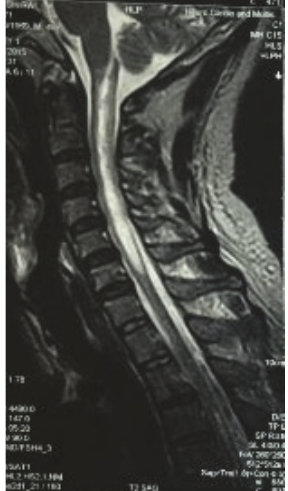
Figure 1: Magnetic resonance imaging of cervical spine; saggittal view of cervical segment of spinal cord is shown. The image shows T2 hyperintense signal in central cervical spinal cord from first to sixth cervical level, showing subtle enhancement and causing expansion of involved